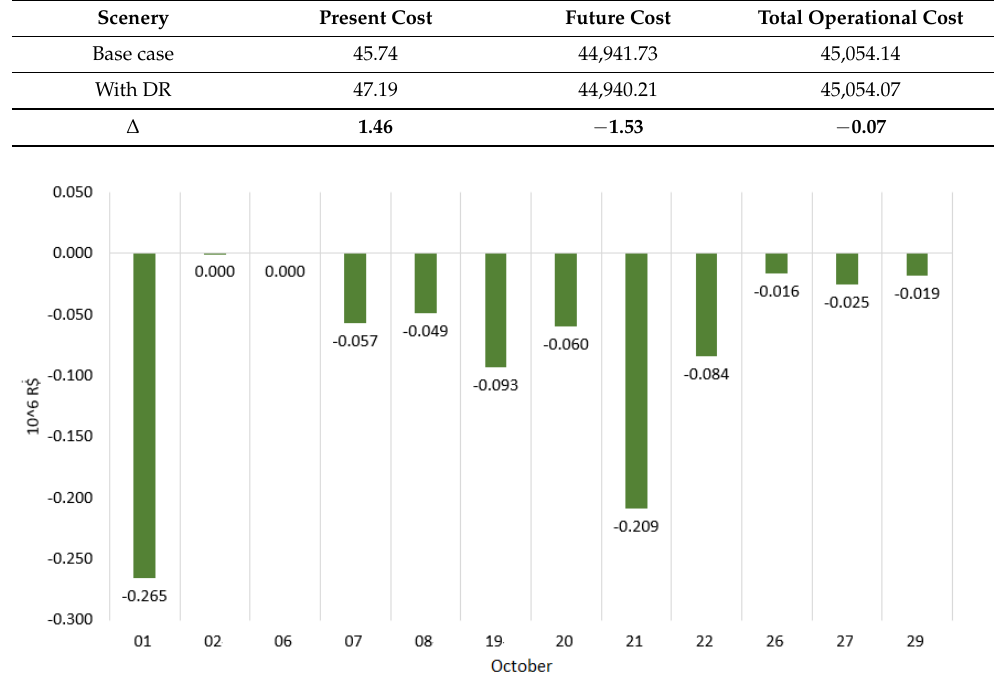
Figure 11. Differences between total operational